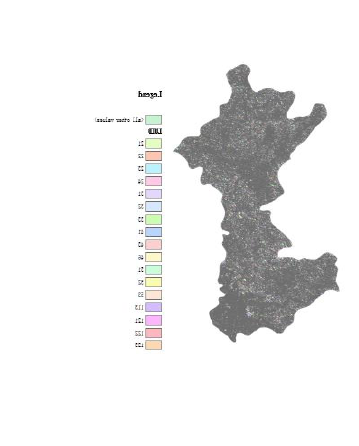
Figure3 ： Land-use and Land-cover of Huairou in 2012